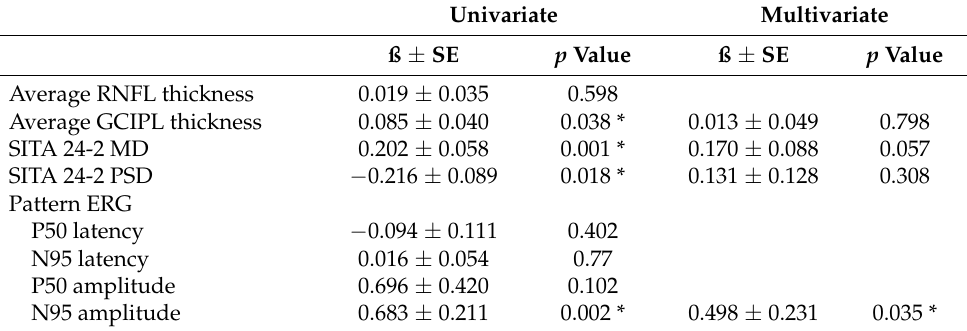
Table 3. Factors associated with the average macular VD in total subjects.